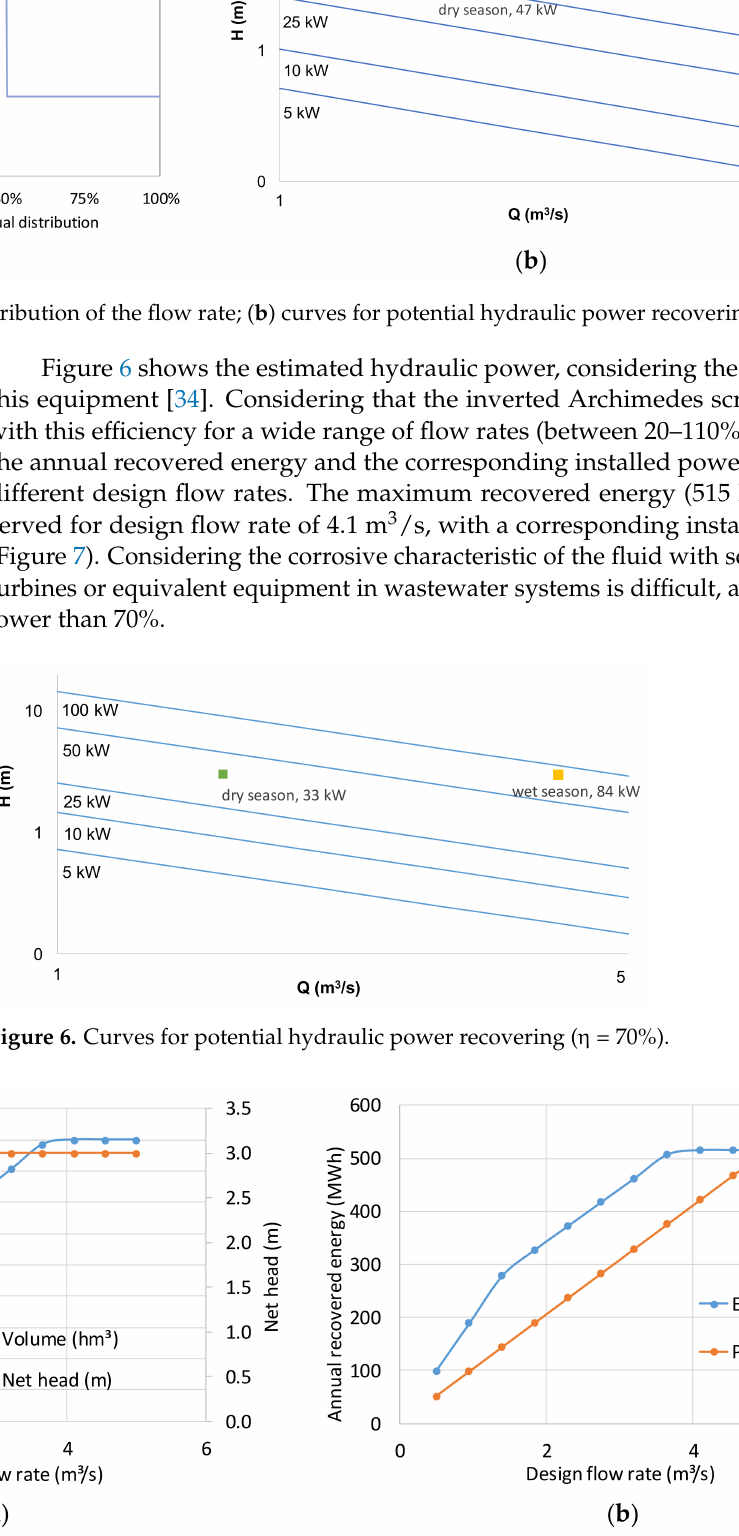
Figure 7. ( a ) Annual turbined volume and net head; ( b ) annual recovered energy and installed power for the Archimedes